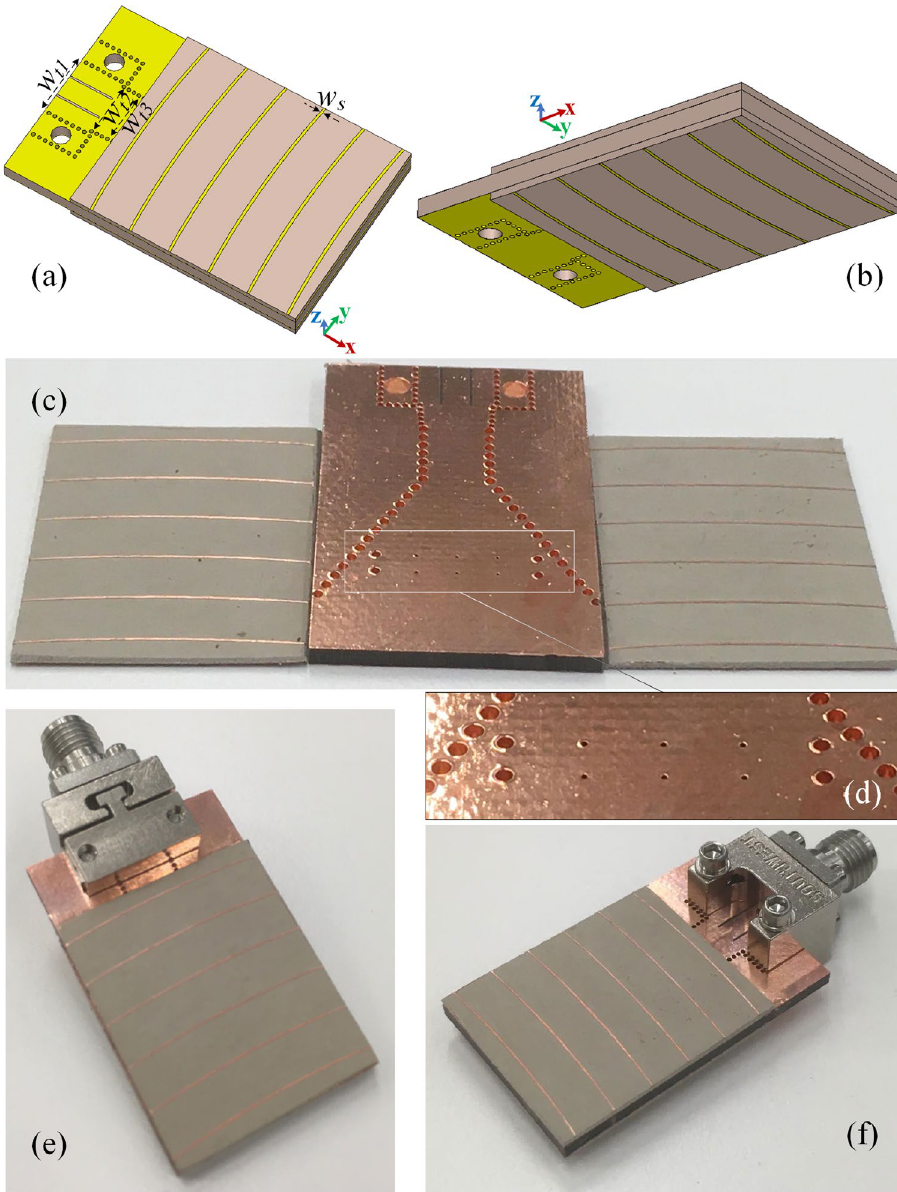
Figure 12. The finalised structure. ( a ) The topside and ( b ) the backside of the simulated structure, ( c ) the fabricated SIW H-plane horn, loaded by the designed modulated metal-via lens, beside the two holographic- based SWRs, ( d ) the magnified view of the modulated metal-via lens, ( e ) the assembled structure from the backside angle of view and ( f ) from the top side angle of